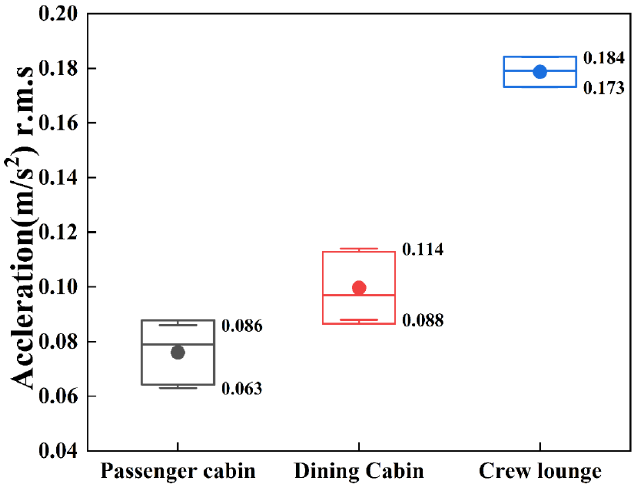
Figure 2. Distribution of vibration acceleration in three cabins.